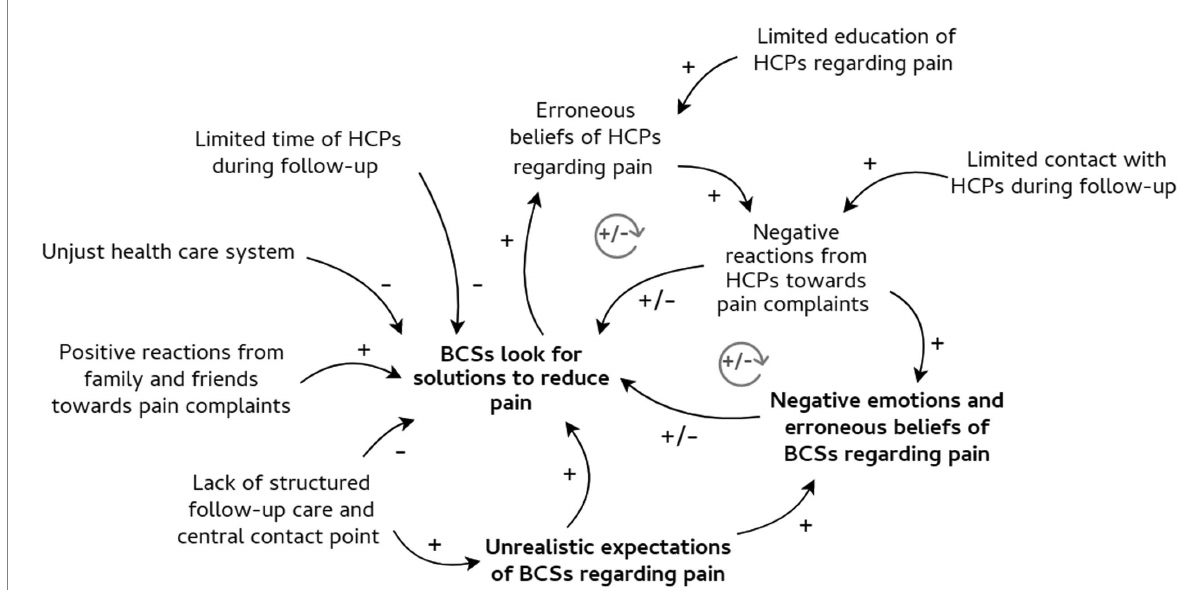
FIGURE 2 Solving pain and influencing processes. Figure shows the pattern of solving pain and its influencing processes, i.e. intrapersonal, interpersonal, and societal processes. The intrapersonal processes are shown in bold. The influencing relationships between processes were translated into words- and-arrows diagrams. The positive arrows represent relationships that reinforce problem-solving behaviour in breast cancer survivors. The negative arrows stand for inhibiting relationships. When a relationship is reciprocal, a circular arrow in grey was added. The following abbreviations were used: BCS, breast cancer survivor; HCP, healthcare provider.